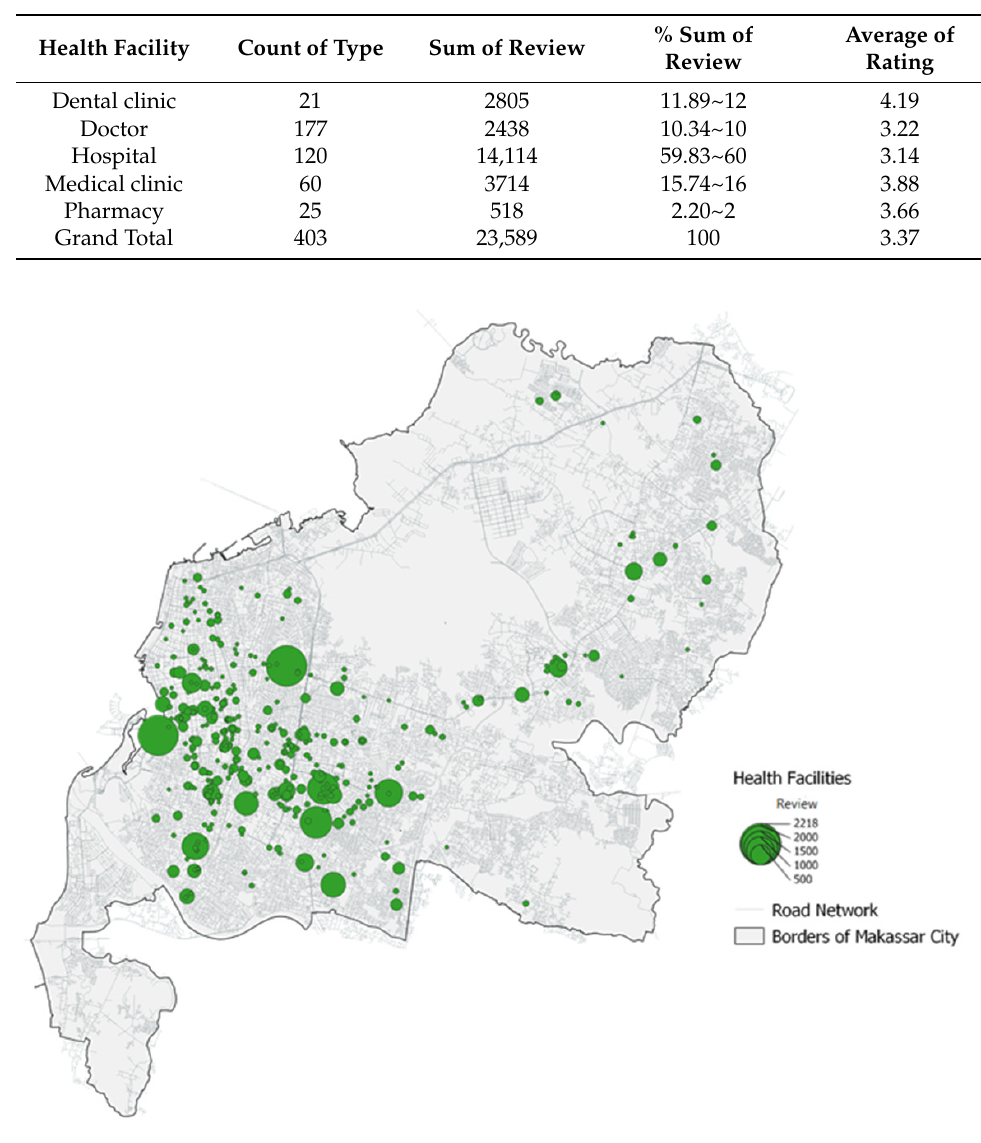
Figure 8. Map of Health Facility Service Perceptions according to Google POI.